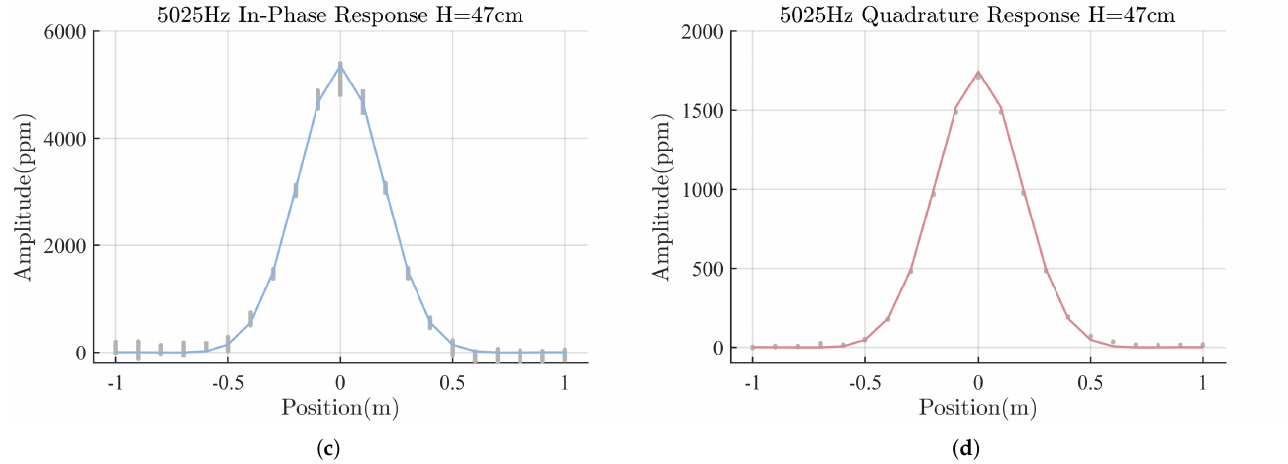
Figure 10. Standard coil simulation (curve lines) and measured (vertical lines) response: ( a ) 5025 Hz in-phase response at H = 76 cm; ( b ) 5025 Hz quadrature response at H = 76 cm; ( c ) 5025 Hz in-phase response at H = 47 cm; ( d ) 5025 Hz quadrature response at H = 47